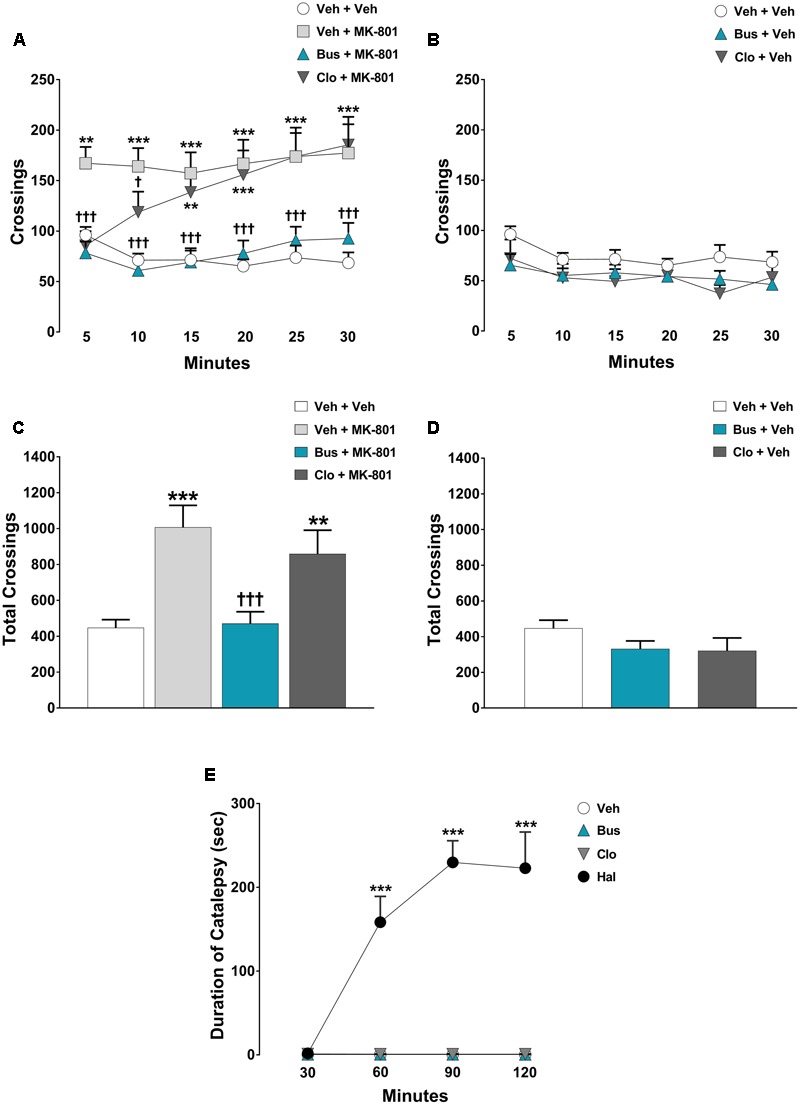
Buspirone blocked MK-801-stimulated hyperlocomotion, but did not cause catalepsy in WT mice. Buspirone (Bus, 3 mg⋅kg-1, i.p.) or vehicle (Veh), clozapine (Clo, 1 mg⋅kg-1, i.p.) or Veh and MK-801 (0.1 mg⋅kg-1, i.p.) or Veh were injected 45 min, 30 min and 20 min respectively, before the open field. (A,B) Locomotor activity (crossings) at each 5-min time point displayed by Veh + Veh (n = 11), Veh + MK-801 (n = 11), Bus + MK-801 (n = 10), Clo + MK-801 (n = 10), Bus + Veh (n = 9), Clo + Veh (n = 9) WT mice. (C,D) Locomotor activity (crossings) over a 30-min test period displayed by the same mice. (E) Duration of catalepsy state 30, 60, 90, and 120 min after drug injection (n = 6 animals/group). Haloperidol (Hal, 1 mg⋅kg-1) was used as positive control. Data are shown as mean ± SEM. ∗∗∗p < 0.001, ∗∗p < 0.01 vs. Veh + Veh WT mice; †††p < 0.001 and †p < 0.05 vs. Veh + MK-801 WT mice; ∗∗∗p < 0.001 vs. Veh (Two-way repeated-measures ANOVA and Newman–Keuls post hoc test).